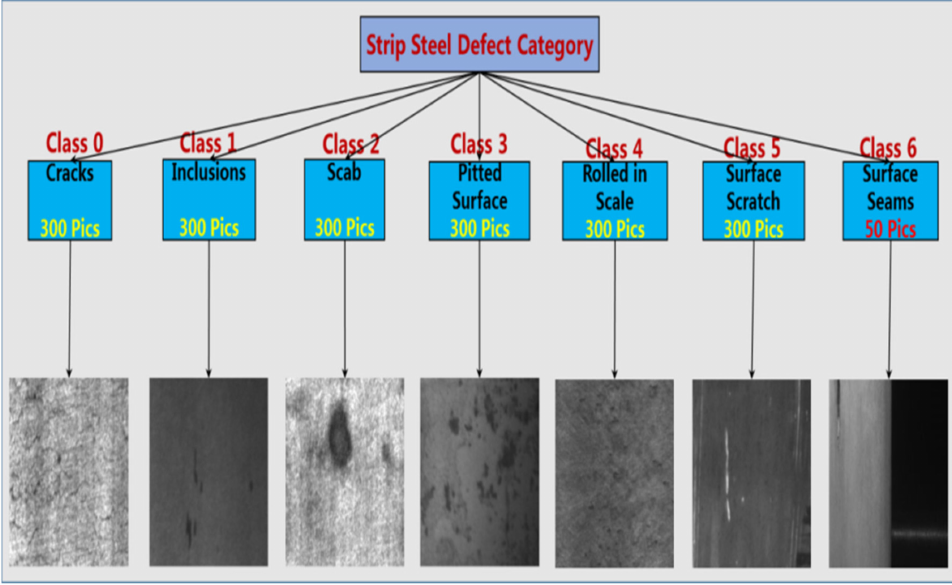
Figure 8. The contrast of our algorithm’s performance on defect-free and defect surfaces.